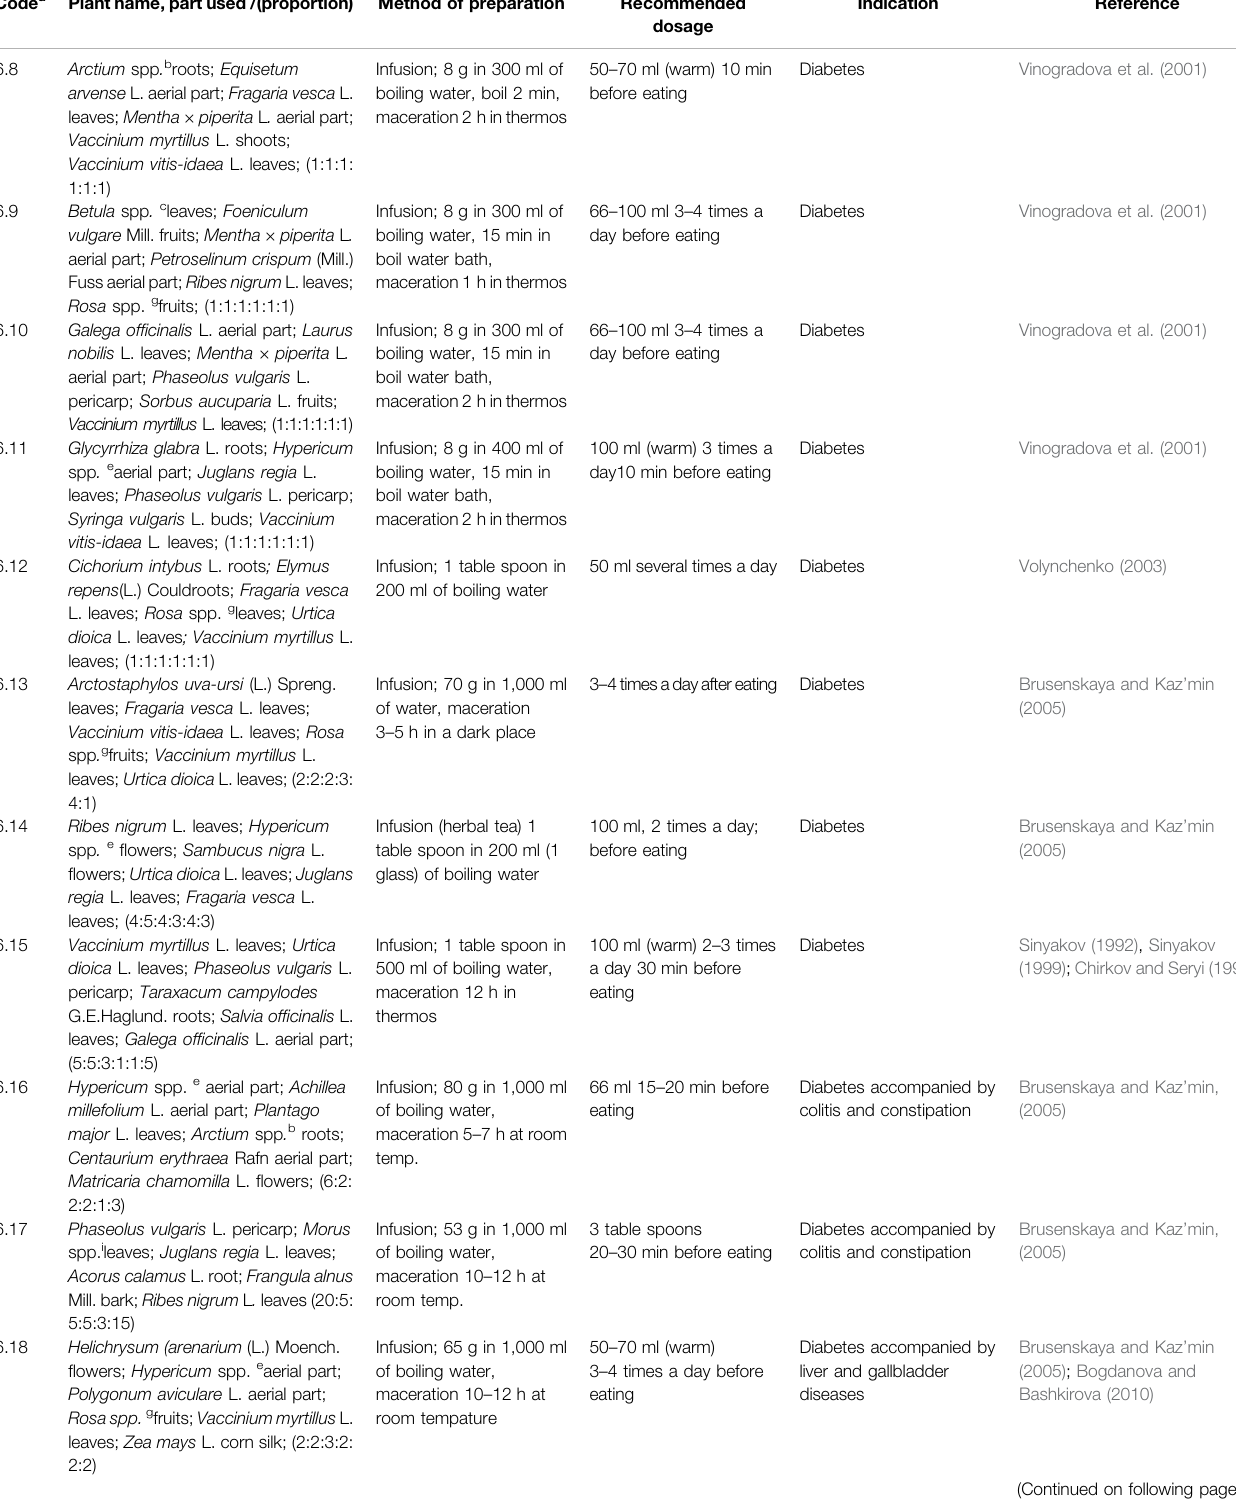
TABLE 1 | ( Continued ) The list of medical species used for the management of diabetes and related disorders in Russia. Code a Plant name, part used /(proportion) Method of preparation Recommended